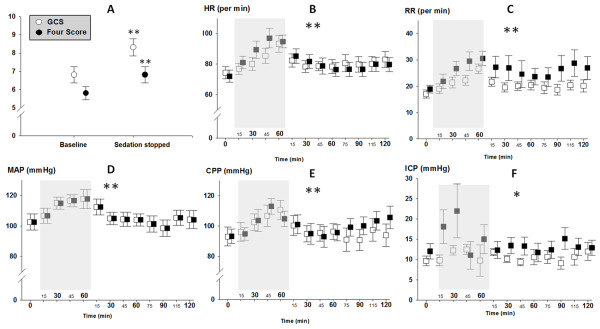
Clinical and hemodynamic changes during is-trials. Panel A shows median increase of GCS (empty circle) and the Four score (filled circle) during the IS-trial. Panel B-F gives average time course of cardiopulmonary, cerebrovascular parameters and ICP (y-axis) at baseline (time = 0) during the trial (grey square) and over 2 hours following restart of sedation and analgesics (x-axis) in patients where the trial was completed (empty square) and aborted (filled square). P-value is given for significant differences of time points (Panel A) or differences of parameters over time (Panel B-F) (** = P < 0.001, * = P < 0.05). On Panel B-F error bars represent means and one standard error of n = 54 individual trials. CPP, cerebral perfusion pressure; HR, heart rate; ICP, intracranial pressure; MAP, mean arterial pressure; RR, respiratory rate.